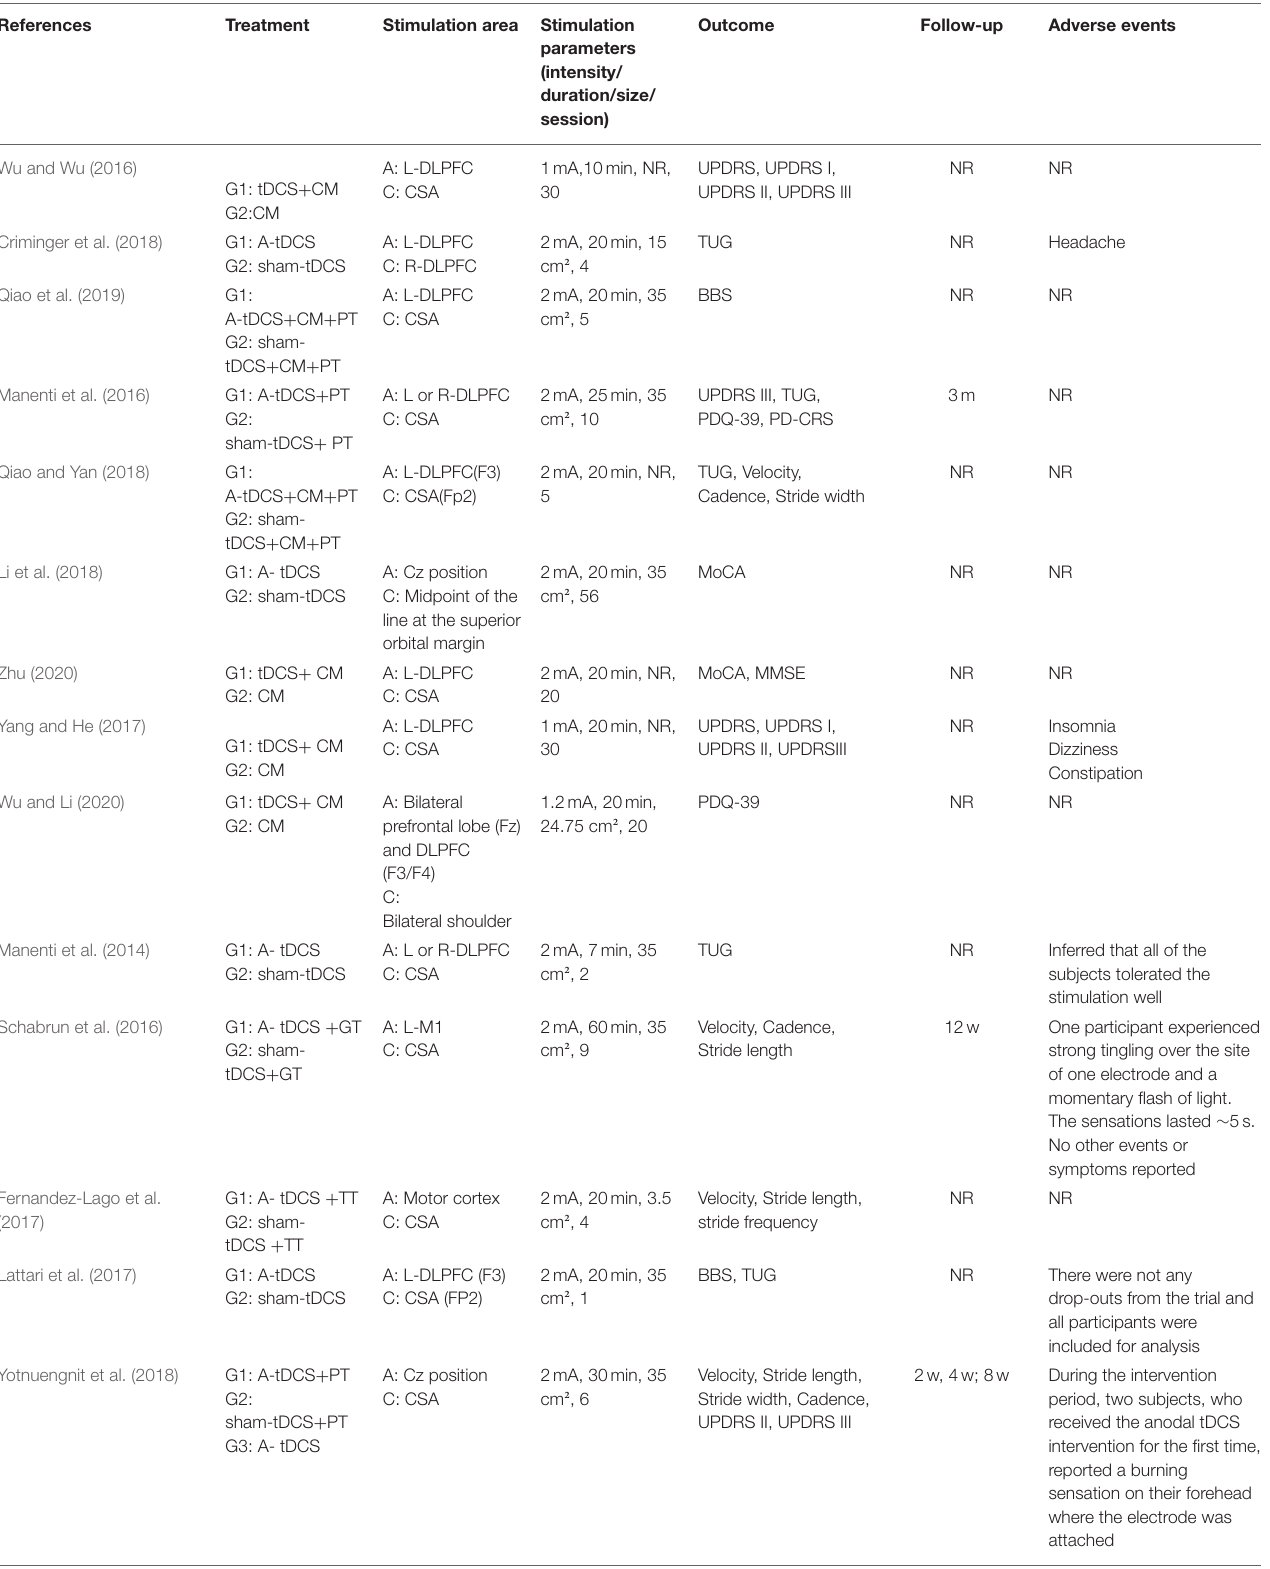
TABLE 2 | tDCS protocols of the included